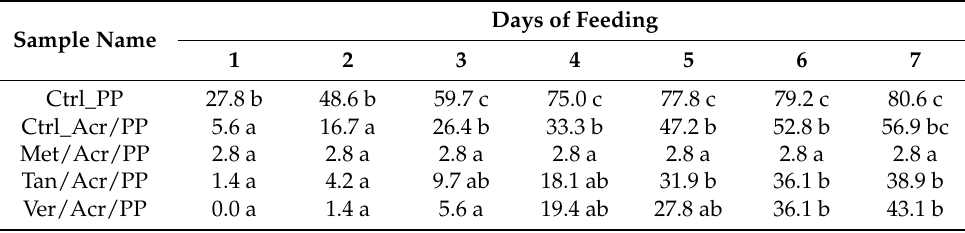
Table 4. The influence of modified non-woven mats on the corrected average damage extent of Napa cabbage discs (average in %), by D. reticulatum and the results of Tukey’s test at the significance level of α = 0.05. a–c—values in columns marked with the same letters do not differ